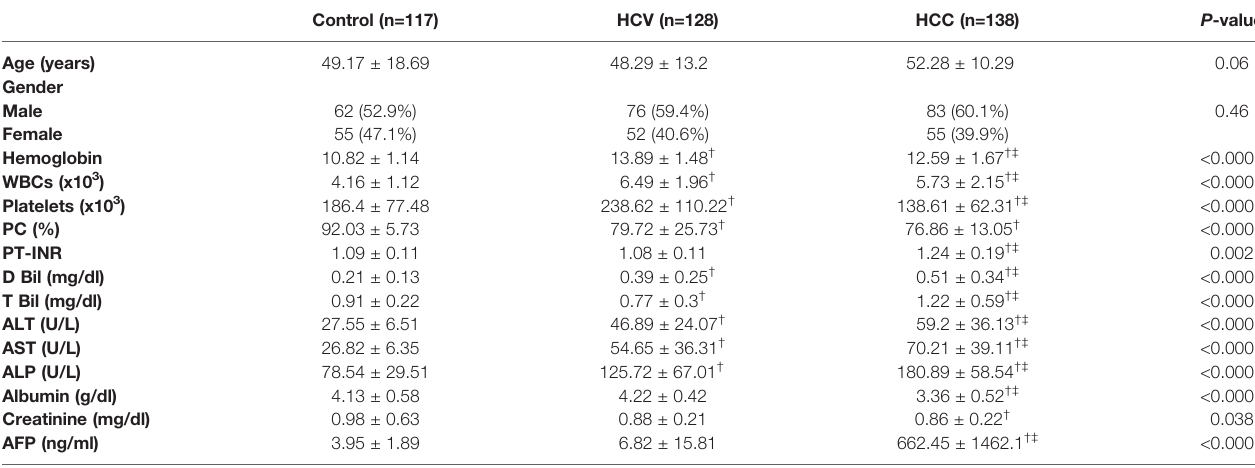
TABLE 1 | Demographic characteristics and laboratory data in the HCV, HCC patients and healthy